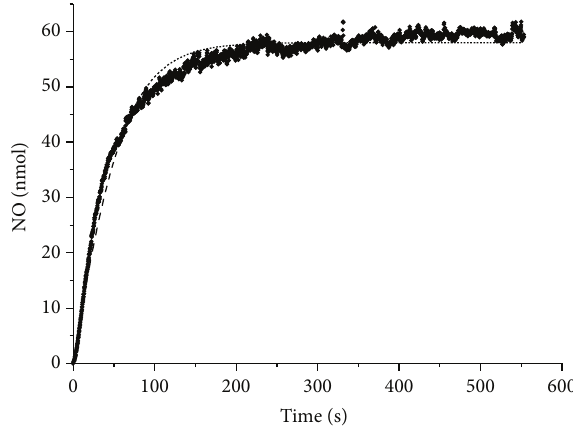
Figure 2: Kinetic curve of the accumulation of NO in solution (the measurements were carried out by a sensor electrode) in the course of the decomposition of ( I ) 4 ⋅ 10 −6 M in 0.05 phosphate buffer pH 7.0 under anaerobic conditions at 25 ∘ C. The dashed line represents the approximation by 𝑑𝑥/𝑑𝑡 = 𝑘 1 ⋅ [( I )] 0 − 𝑘 1 ⋅ 𝑥 − 𝑘 𝑛 ⋅ 𝑥 2 . ( I ) is the